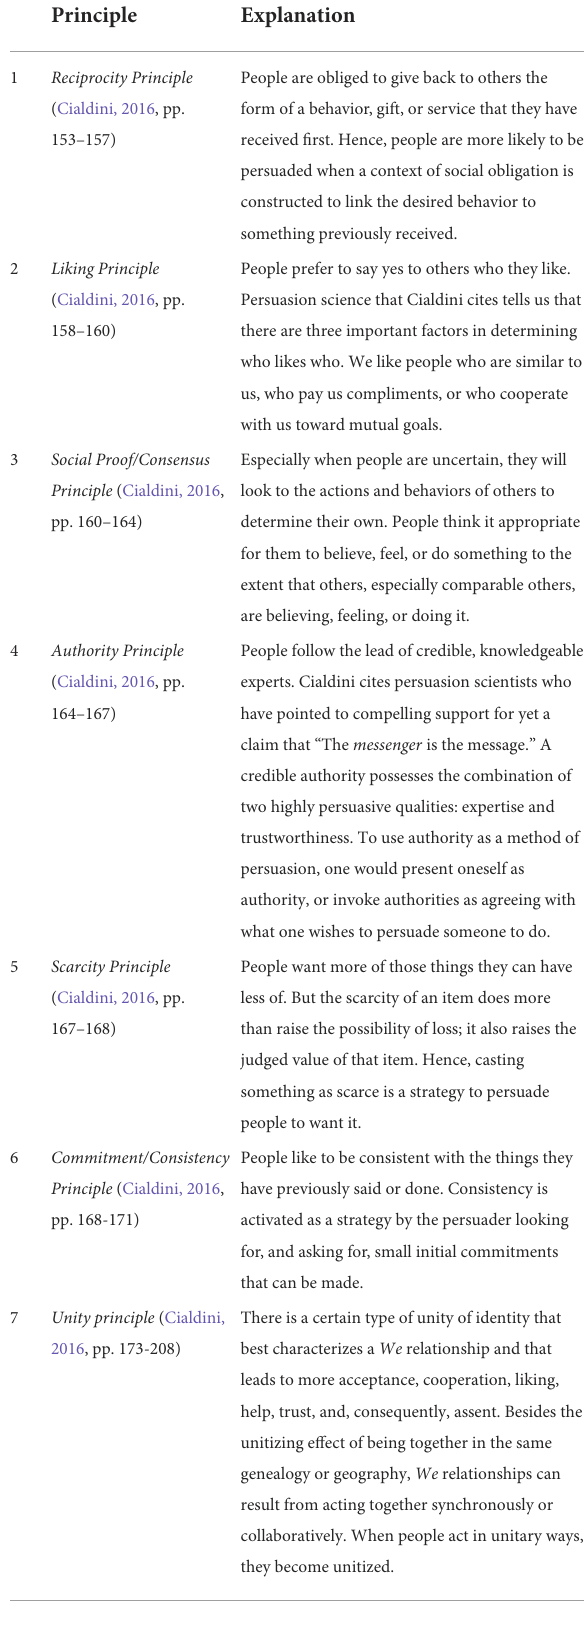
TABLE 1 Cialdini’s Principles of Influence (adapted from Cialdini, 2016, pp.